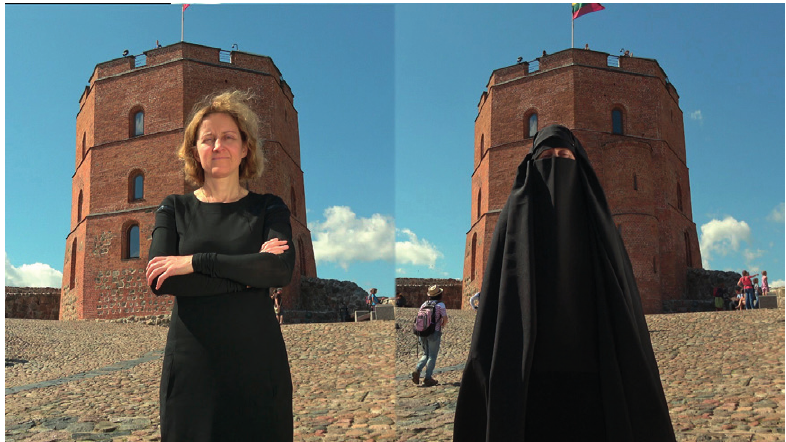
Figure 4. Sigita Maslauskaitė-Mažylienė. Partition: Niqab